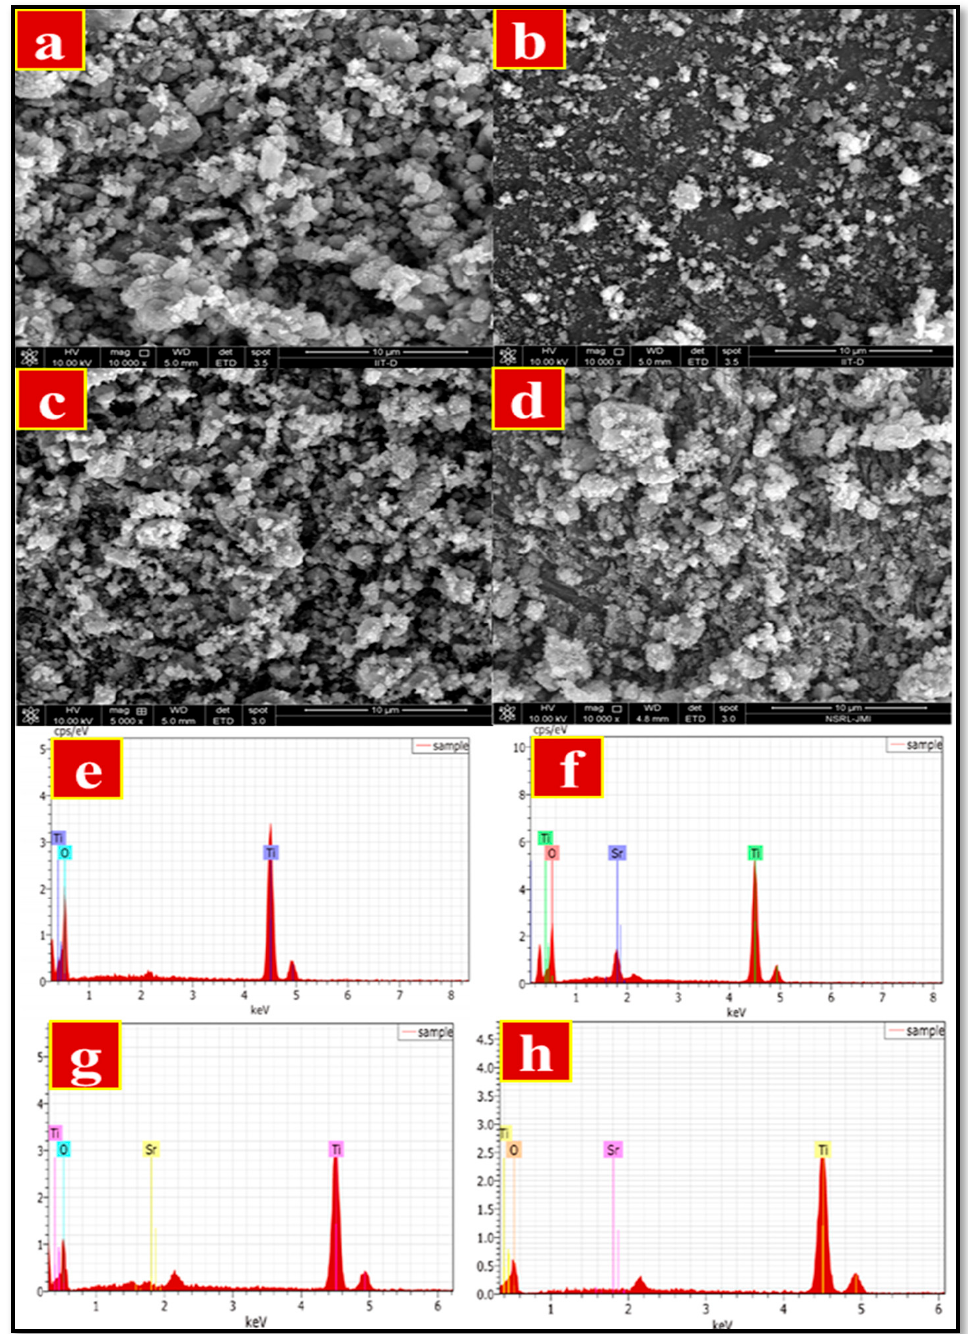
Figure 5. ( a – d ) SEM micrographs and ( e – h ) EDAX spectra of Pristine TiO 2 , 1%, 2.5%and 5% Sr-doped TiO 2 nanoparticles.